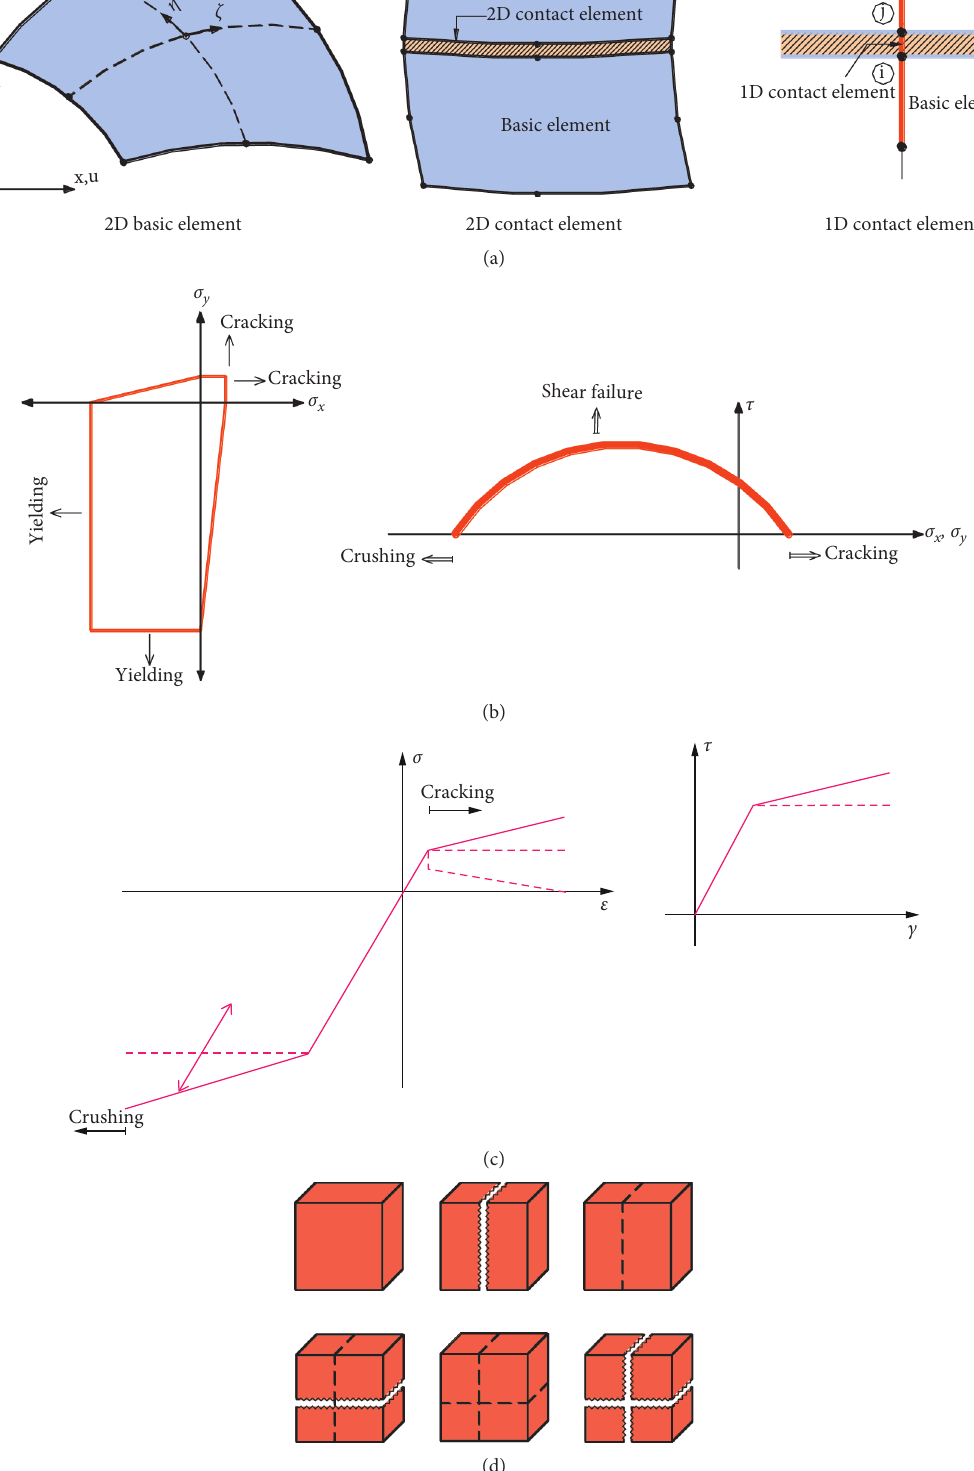
Figure 10: The graphical presentation of the adopted 2D nonlinear numerical model: (a) finite elements, (b) constitutive model for basic materials, (c) constitutive model for contact elements, (d) possible crack patterns